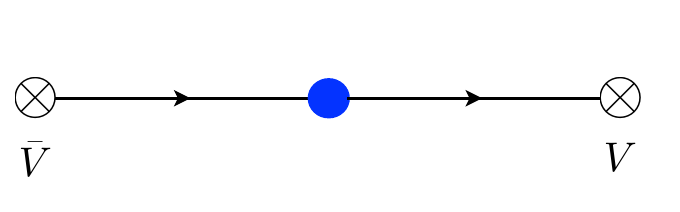
Figure 2 . A one-particle state on the worldsheet may be represented as a free quark with two conjugate (cid:13)ux lines emanating in opposite directions and terminating at the boundary charges at